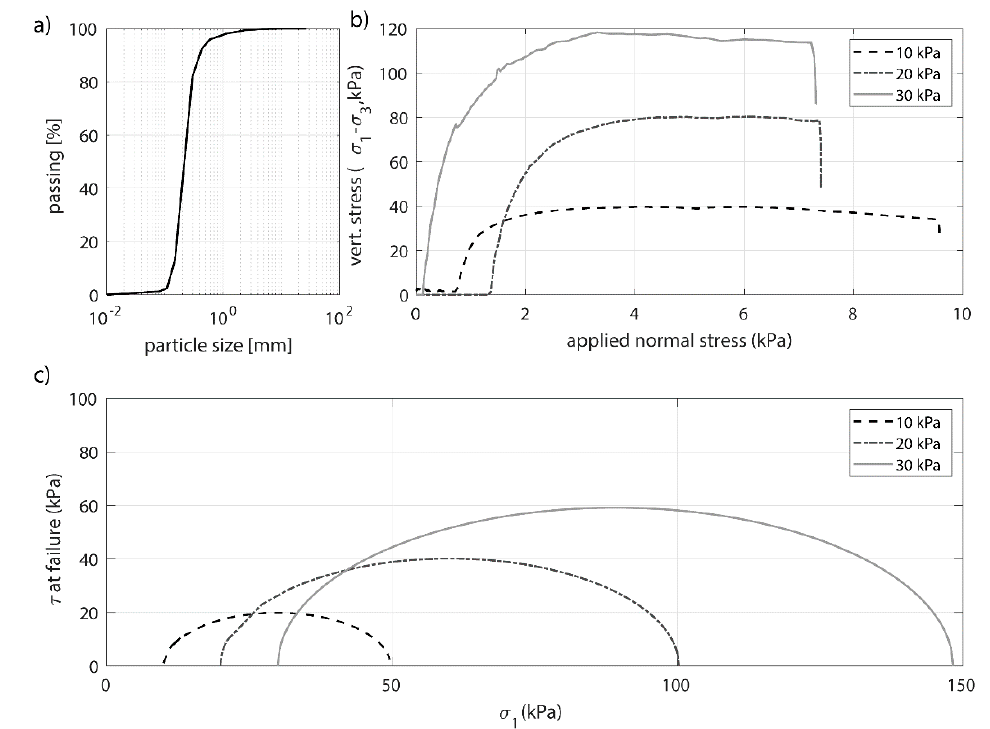
Figure 6. ( a ) Average particle size distribution of the seabed sediment found within the candidate site. ( b ) Top right panel shows the deviatoric stress vs. the vertical stress. ( c ) Bottom panel depicts Mohr circles at failure state with failure plane and the tangent used to determine the friction angle indicating cohesionless and coarse sand particles.